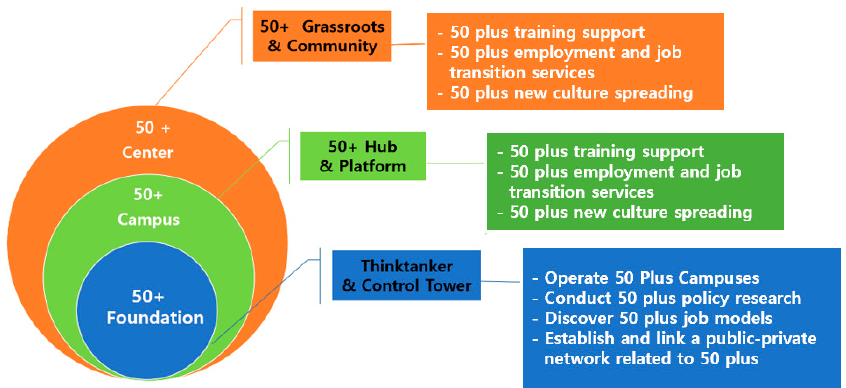
Figure 3. Structure of the Seoul 50 Plus Foundation (Reference: Seoul 50 Plus Foundation’s Annual Report).